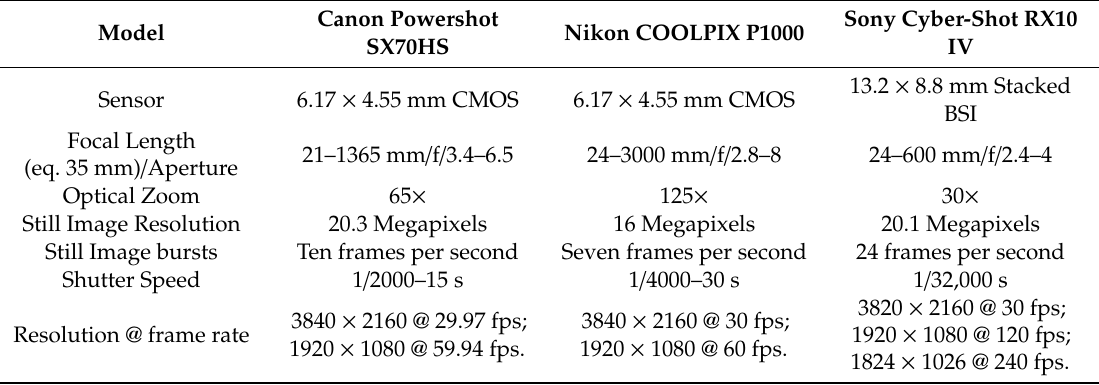
Table 1. Some of Common Market available bridge cameras